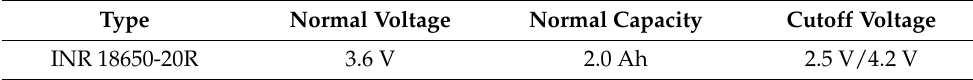
Table 1. Basic Information about the